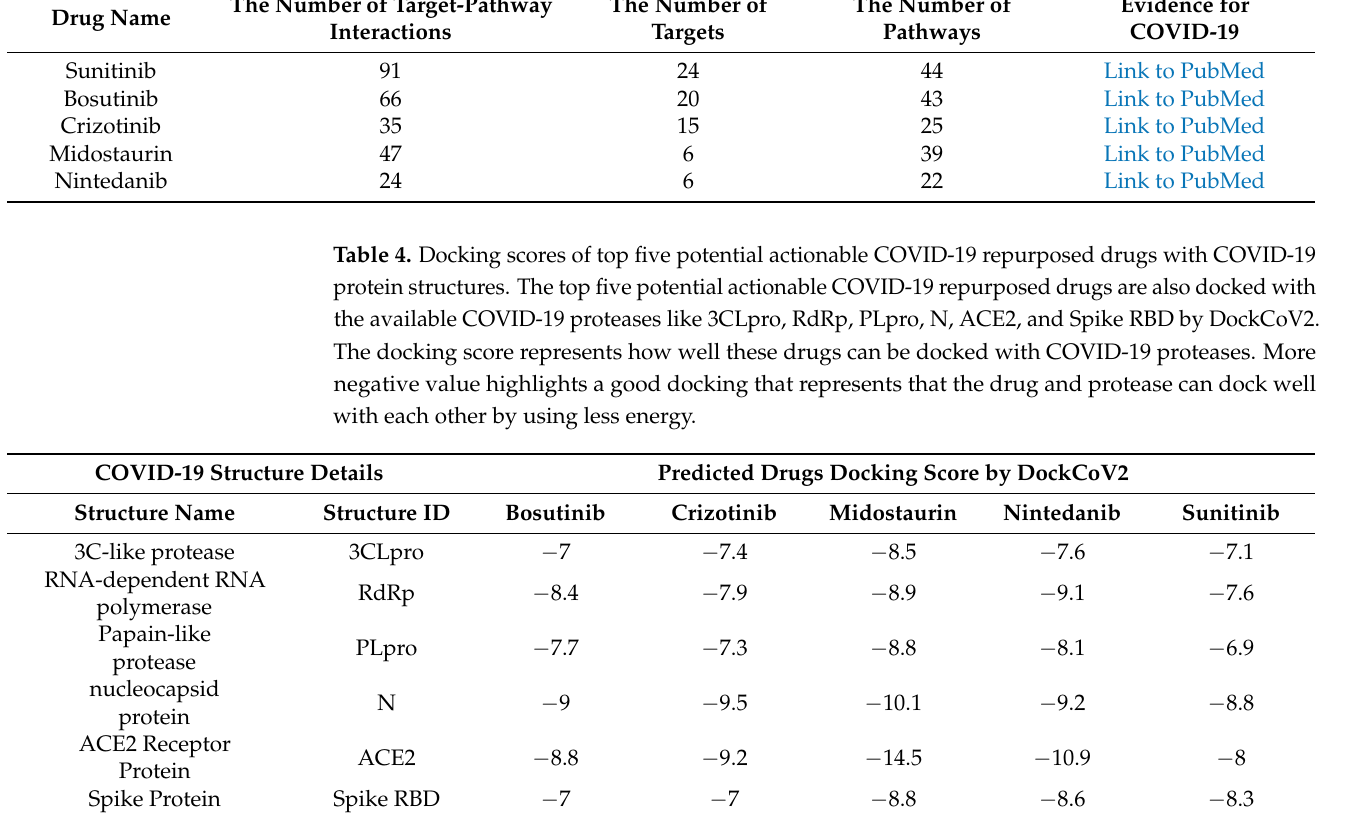
Table 5. Best pose Links of the docking of top five potential actionable COVID-19 repurposed drugs with COVID-19 protein structures. DockCoV2 also generates the best docking pose for each of the top five detected potential COVID-19 drugs and COVID-19 proteases, the link of which is hyperlinked in the table